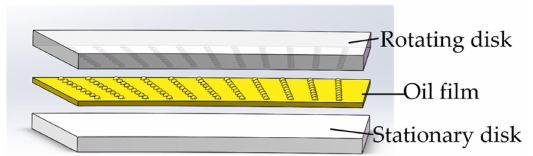
Figure 14. Schematic diagram of friction pair